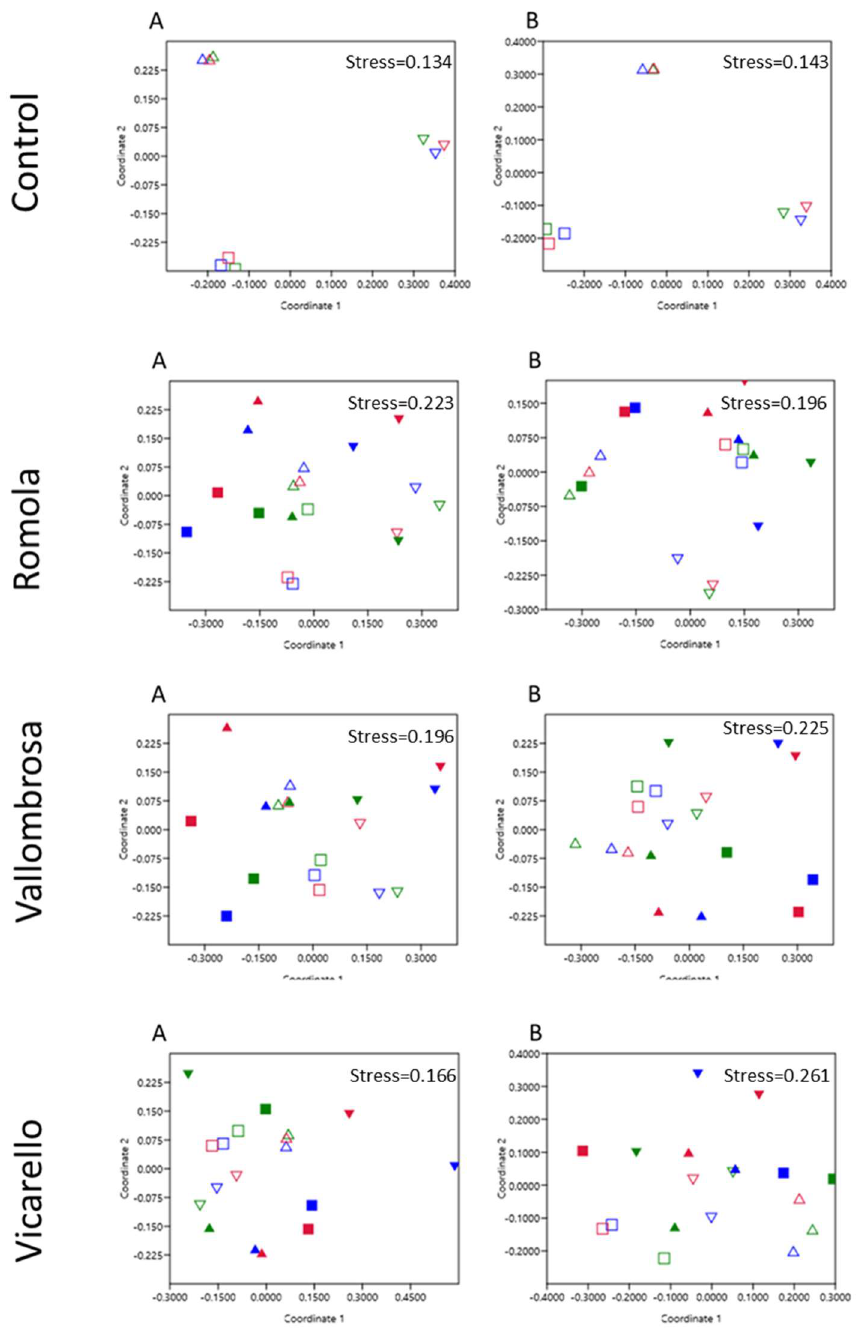
Figure 4. NMDS ordination plots of 16S ( A ) and 18S ( B ) rRNA gene DGGE profiles obtained from Vallombrosa (empty triangle), Vicarello (empty inverted triangle) and Romola (empty square) control soils and from sterilized soils reinoculated with Vallombrosa (filled triangle), Vicarello (filled inverted triangle) and Romola (filled square) soils, incubated for 1 (green), 7 (blue) and 30 days (red).